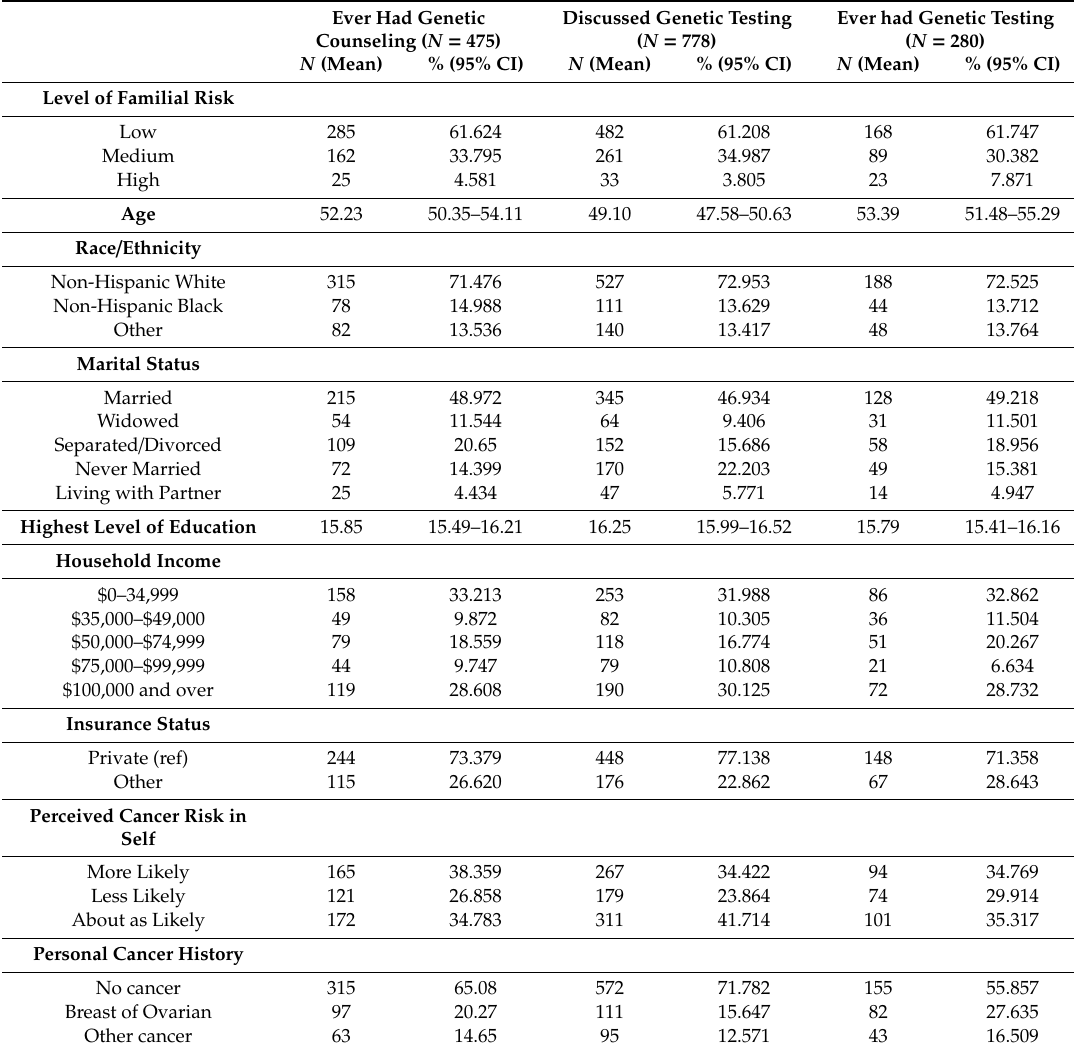
Table 1. Characteristics of Individuals by Knowledge and Use of Genetic Counseling and Testing for